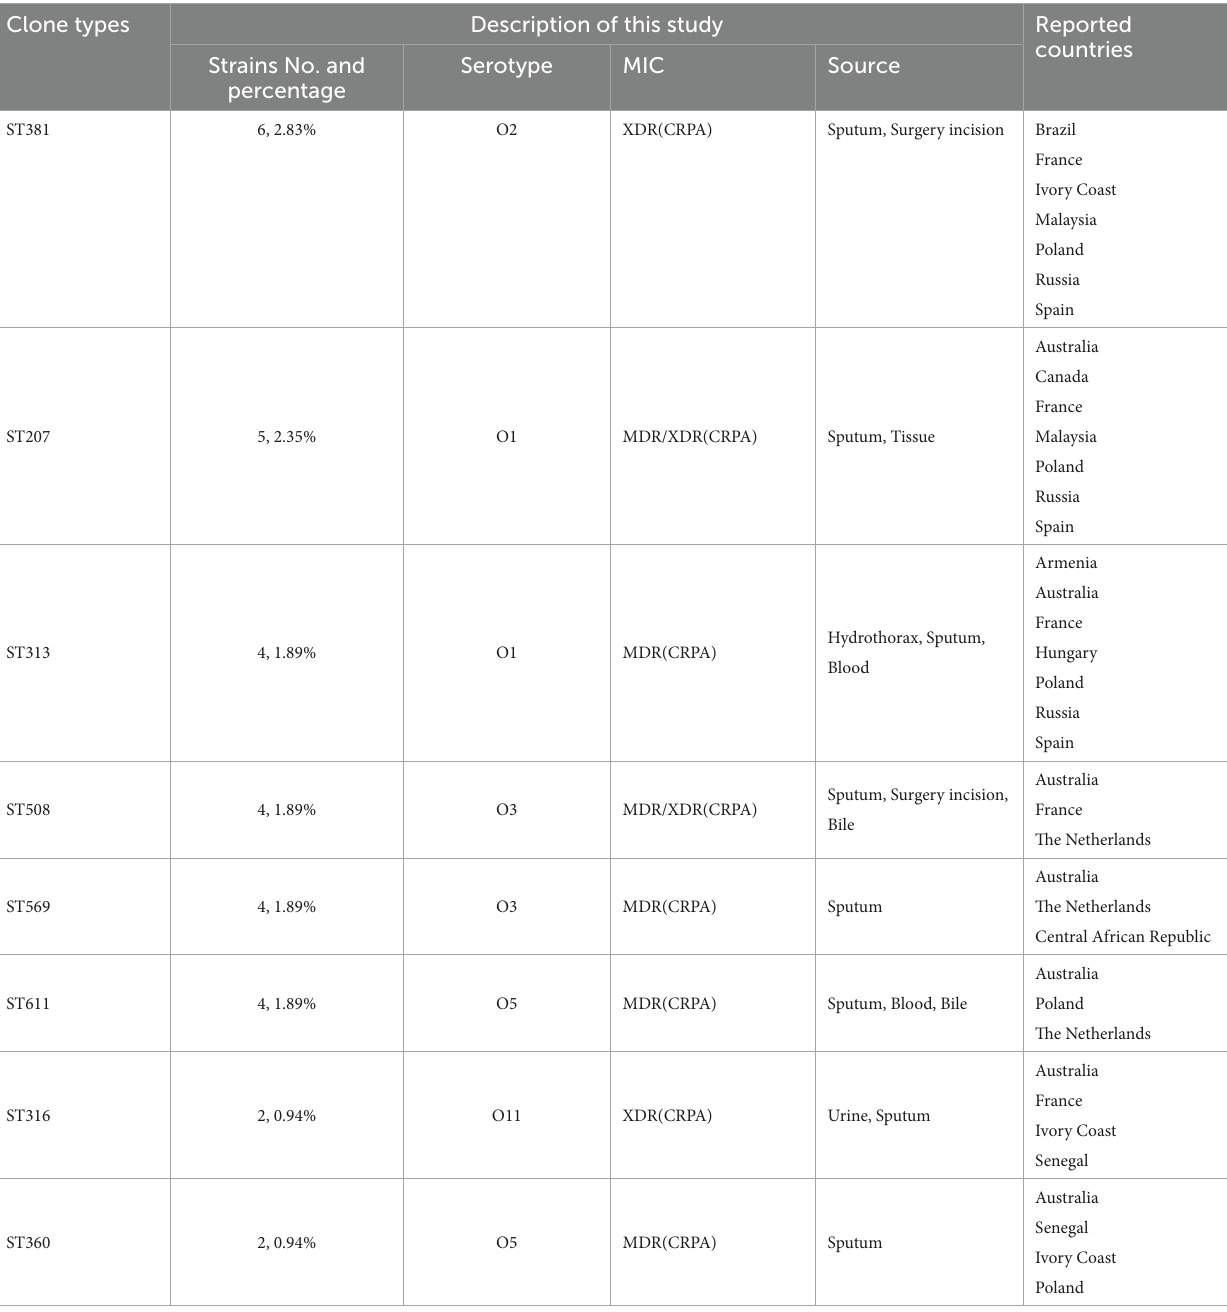
TABLE 2 The successful clones identified in this study with potential risks. Clone